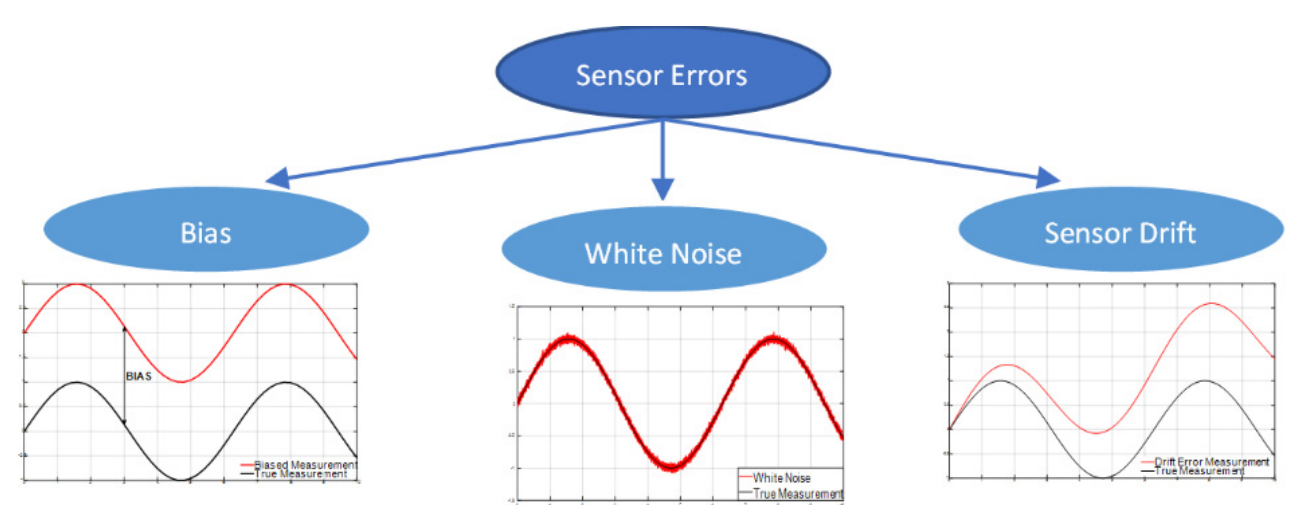
Figure 3. Types of sensor errors simulated in the tests.